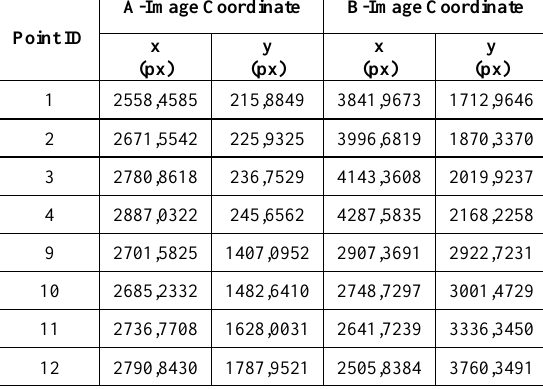
Table 1. Markers’ Image Coordinates